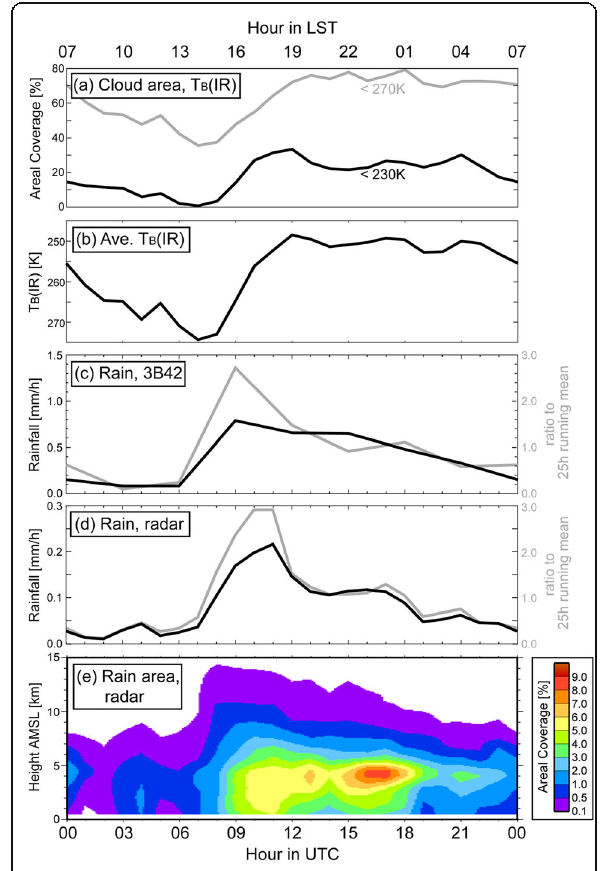
Fig. 5 Diurnal composite of precipitation and clouds, expressed by a spatial coverage of the infrared brightness temperature (T B (IR)) less than 230 K (black) and 270 K (gray), b the averaged T B (IR), c the rain rate from the TRMM 3B42, d the rain rate from the Serpong C-band radar, and e the vertical profile of the spatial coverage of the Serpong C-band radar echo with > 20 dBZ. All parameters are calculated within the area of the sounding array as in Fig. 1